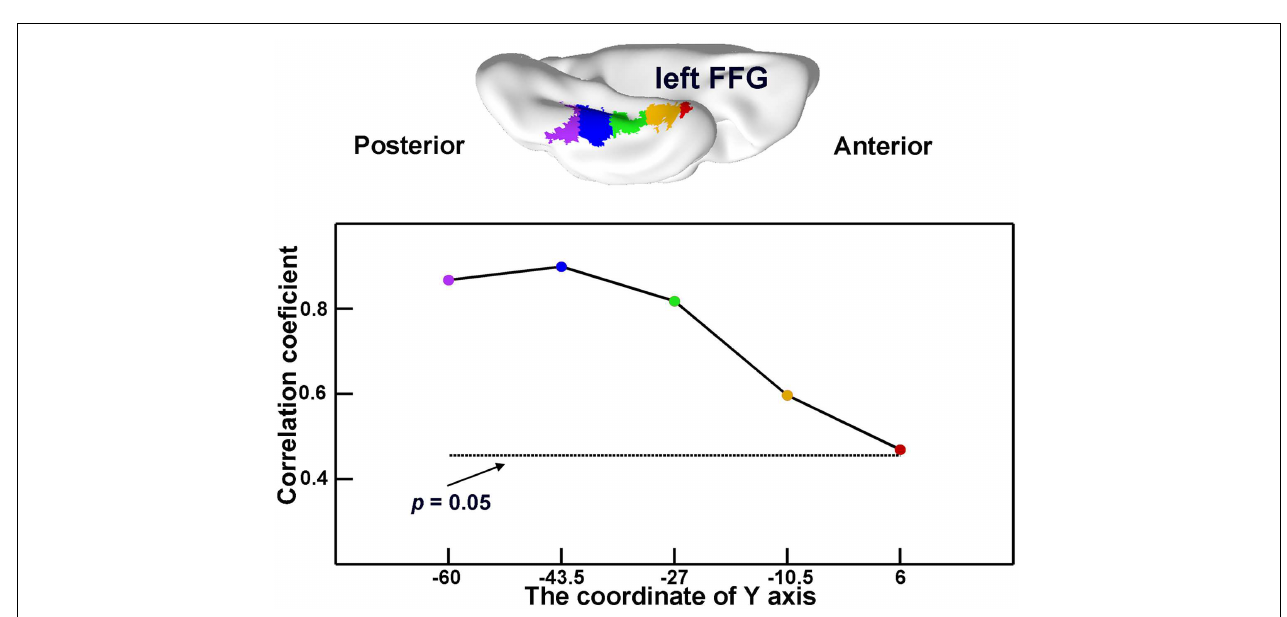
FIGURE 3 | Correlations between semantic performance and the GMVs on SD-semantic-correlated regions that were derived from region-based analysis (RBA; A) or voxel-based analysis (VBA; B). The first column is the schematic of the SD-correlated regions in SD individuals. The middle column indicates the correlations between the GMVs of each region with the semantic PCA scores. The right column is the partial correlation between the GMVs of each region and the PCA scores, after controlling for the GMVs of other SD-correlated regions. ∗∗∗ p < 0.001. FFG, fusiform gyrus; PHG, parahippocampal gyrus.